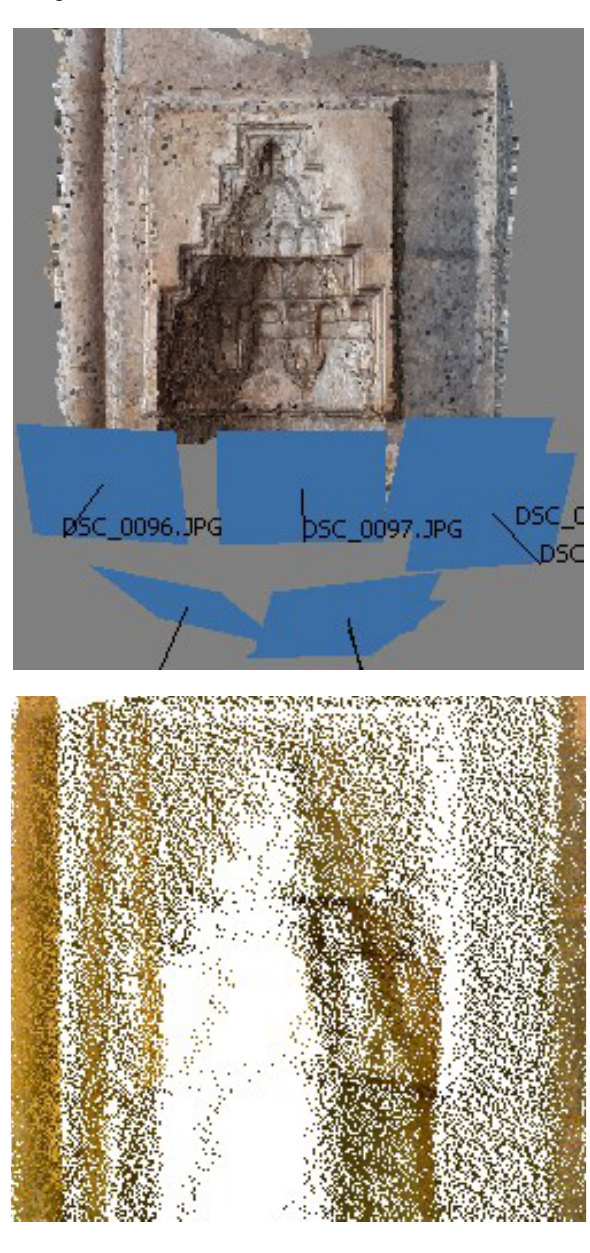
Figure 8. Dense image matching point cloud model (on the top), and laser scanning point cloud model with occlusion that was not imaged by